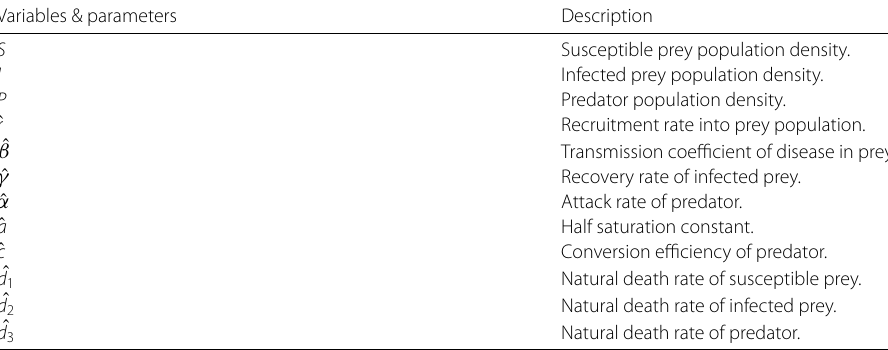
Table 1 Table of the biological description of variables and parameters Variables & parameters Description S